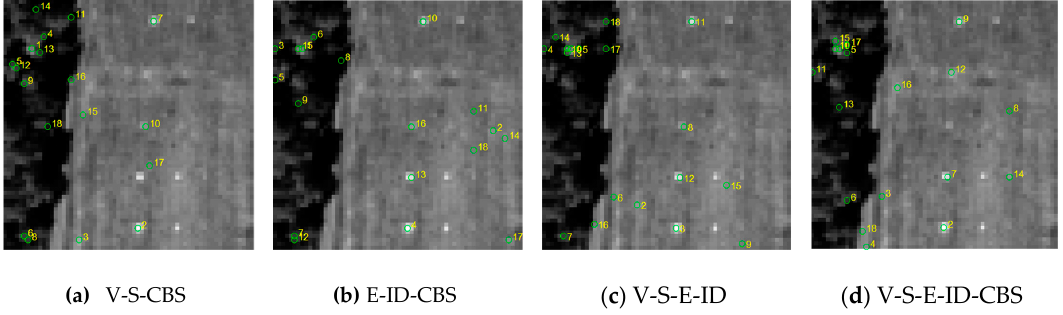
Figure 5. 18 pixels found by ATGP using SBSF and the selected bands in Table 2.